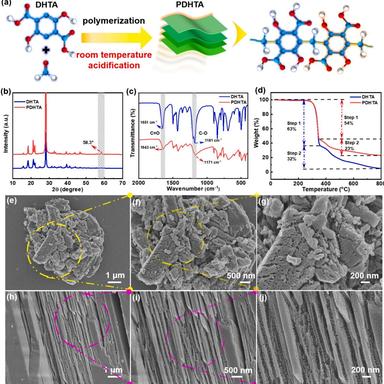
(a) Synthesis process of PDHTA; (b) XRD patterns of DHTA and PDHTA; (c) FT-IR spectra of DHTA and PDHTA; (d) TGA curves of DHTA and PDHTA; (e–g) SEM images of DHTA flake particles; (h–j) SEM images of PDHTA nano-layers.